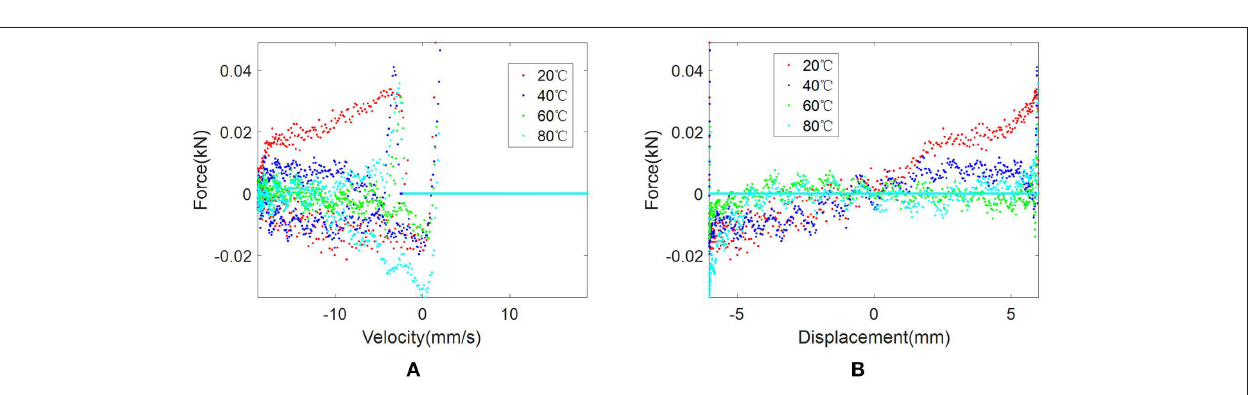
FIGURE 4 | Differences of experimental results and ideal symmetric loops under different currents: (A) force vs. velocity and (B) force vs. displacement.